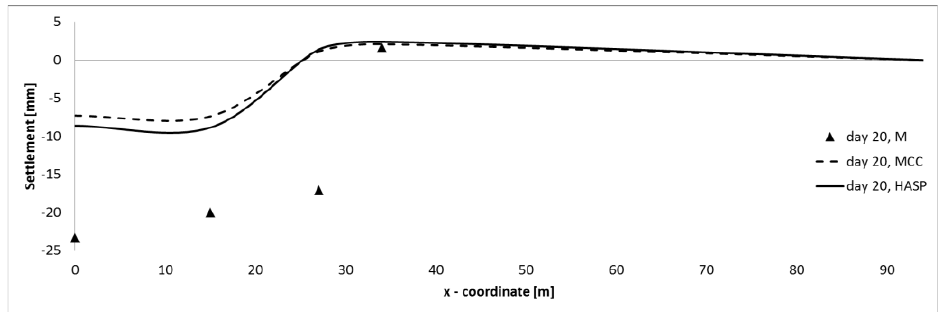
Figure 20. Comparison of the settlement of the ground surface for Embankment B — day 20.